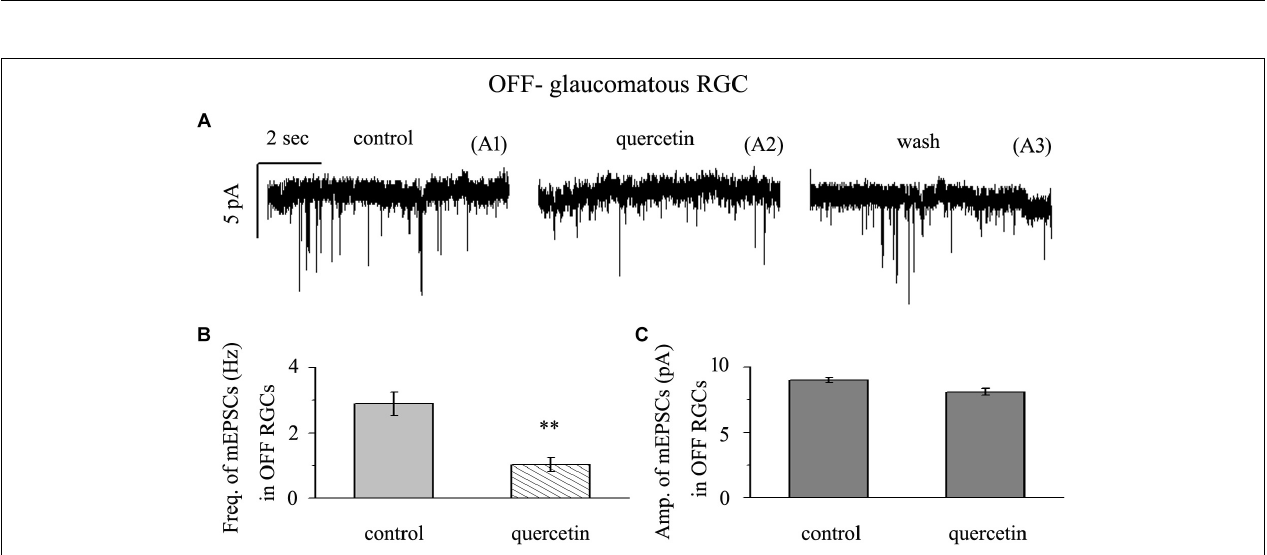
FIGURE 5 | Quercetin significantly increased the frequency, but not the amplitude, of mIPSCs in ON-type RGCs. (A) Representative recordings showing that quercetin increased the frequency but not amplitude of mIPSCs. ( A , top) control condition; ( A , middle) during quercetin treatment; ( A , bottom) recovery period. Vertical bar, 10 pA; horizontal bar, 1 s. (B,C) Cumulative interevent interval and amplitude distributions of mIPSCs in a representative neuron during a control recording and after quercetin application. Quercetin significantly shifted the distribution of interevent intervals to the left (B) but did not shift the distribution of mIPSC amplitudes (C) . The quercetin-induced changes in the distribution of interevent intervals were statistically significant ( n = 11). ∗∗ p < 0.01, Kolmogorov–Smirnov test. (D,E) Summarized data for the frequency (D) and amplitude (E) of mIPSCs (frequency: n = 13; amplitude: n = 9). ∗∗ p < 0.01, paired Student’s t -test.